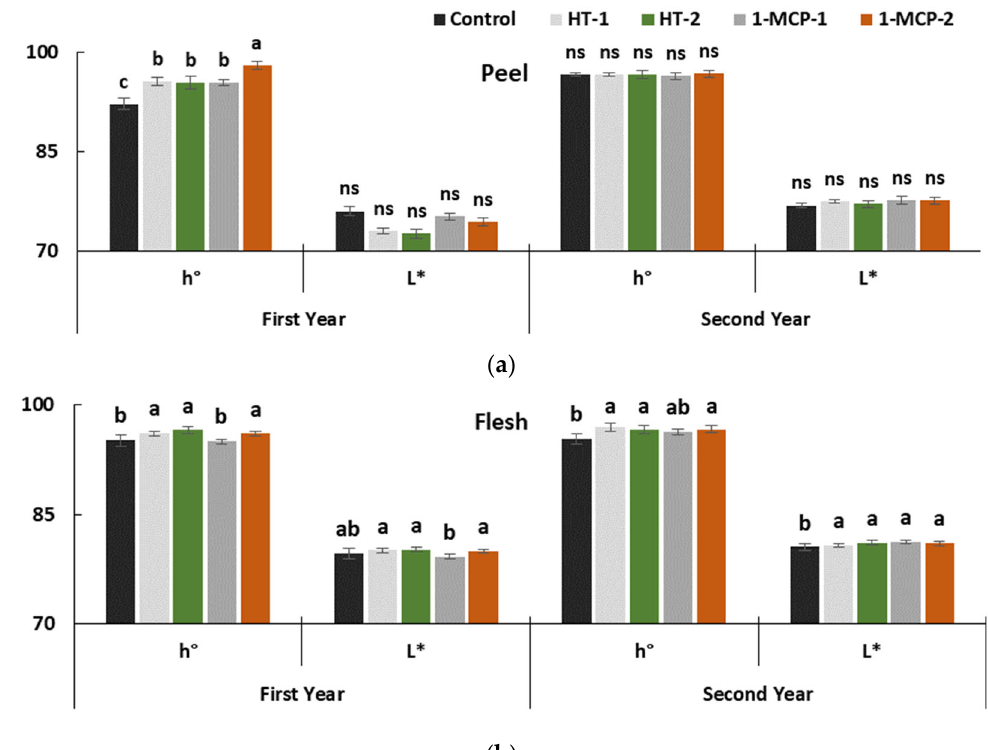
Figure 2. The effect of different postharvest treatments on peel ( a ) and flesh ( b ) color of quince fruit during long-term cold storage period of 6 months at 0 ± 1 ◦ C, 85–90% relative humidity and regular air conditions. Control—without postharvest treatment; HT-1—Hot water treatment at 50 ± 1 ◦ C for 3 min; HT-2—Hot water treatment at 50 ± 1 ◦ C for 5 min; 1-MCP-1—300 ppb 1-methylcyclopropane (1-MCP) treatment at 12 ◦ C for 20 h; 1-MCP-2—1000 ppb 1-MCP treatment at 12 ◦ C for 20 h. Vertical lines are the standard error of means. Different letters are significantly different, according to Tukey test, at p ≤ 0.05 significance level; ns—not significant at p ≤